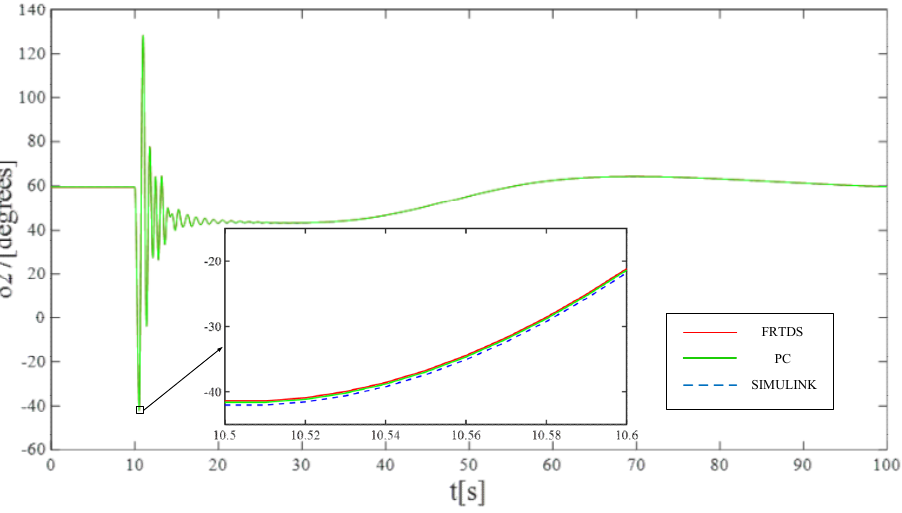
Figure 13. The power-angle of the generator connected to bus 27.